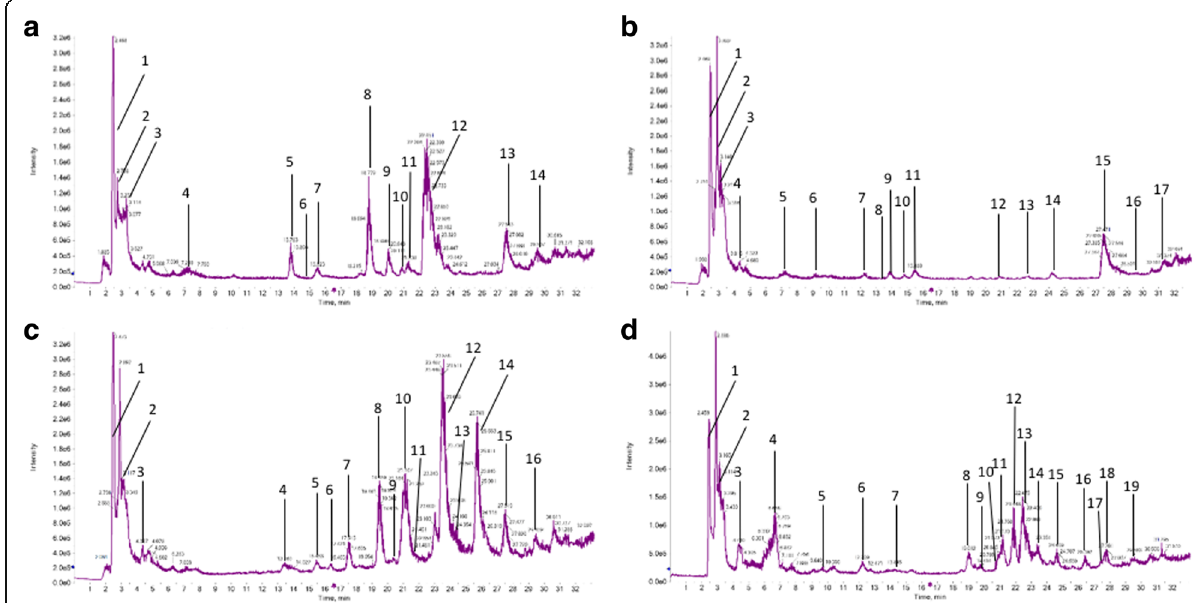
Fig. 2 Chromatograms from E. acoroides leaf extract ( a ), E. acoroides root extract ( b ), H. ovalis leaf extract ( c ) and H. pinifolia leaf extract ( d ) from minute 0 – 33. The relative intensity of mass between 100 and 800 Da is shown. Numbers indicate putatively identified substances in Table